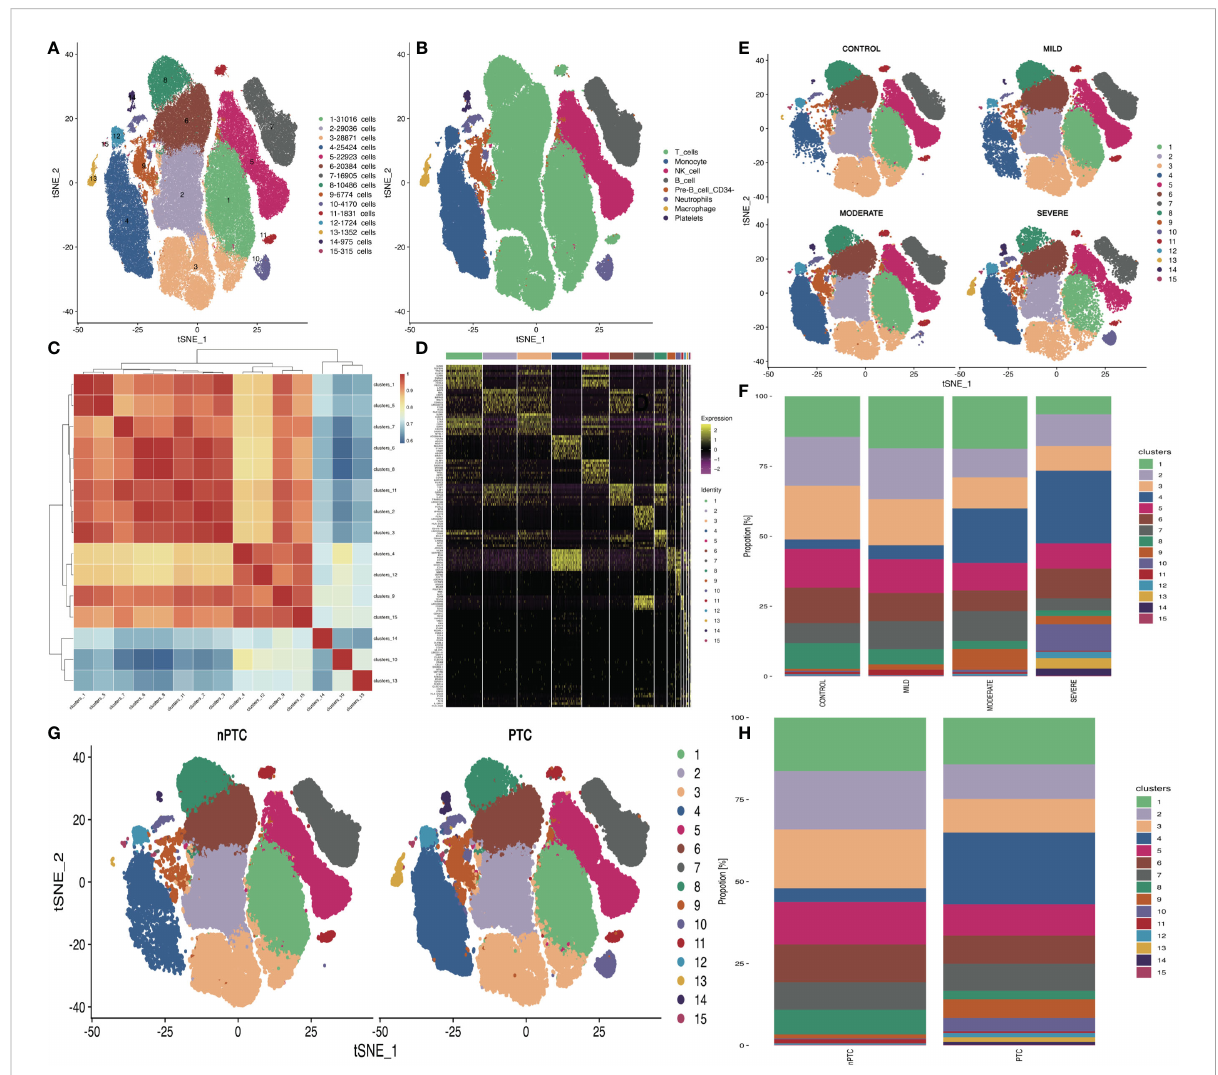
FIGURE 1 The differences in cell subsets of PBMCs in TBI patients. (A) t-SNE plot shows the 15 cell subsets in all PBMC samples from 12 TBI patients and 4 healthy controls. (B) Cell annotations in eight clusters. (C) Correlations of 15 cell subsets are analyzed with Pearson method for the mean expression of genes between each cluster to investigate the similarity between each cell cluster. The X - and Y -axis is each cell cluster. The red color indicates the higher correlation similarity, while the blue color suggests the lower correlation. (D) Top 10 cell markers in each cluster. (E) The t-SNE distribution of 15 cell subsets in different TBI groups. (F) The bar plot of 15 cell subsets ’ distribution in different TBI groups. (G) The t-SNE distribution of 15 cell subsets ’ distribution in nPTC and PTC groups. (H) The bar plot of 15 cell subsets in nPTC and PTC